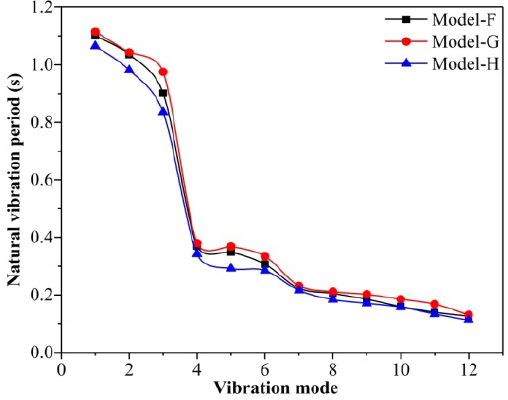
Figure 17. Comparison of natural vibration period.